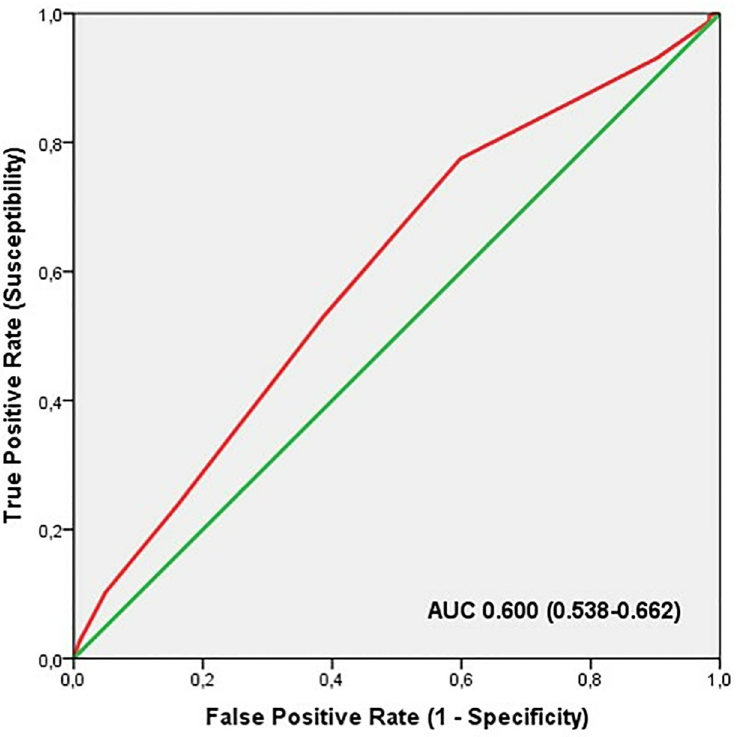
Fig 8. ROC curve summarising the ability of TGS for muscle injuries genes to distinguish potential professional athletes from